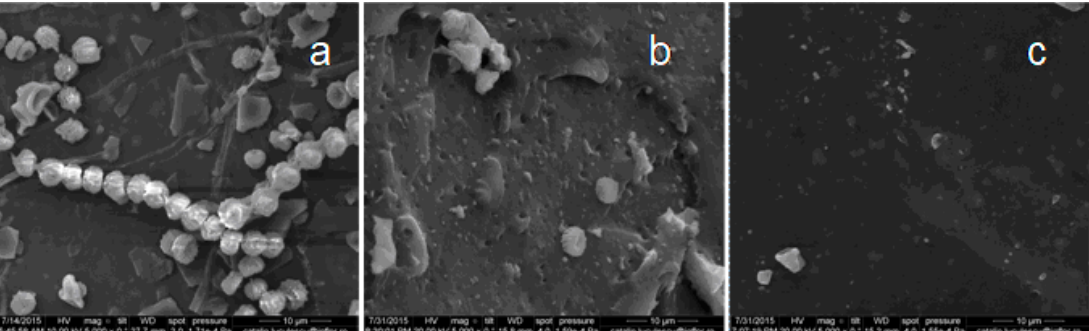
Figure 17. SEM of the natural rubber vulcanizate (A sample). ( a ) after 60 days of incubation with Aspergillus niger ; ( b ) after 60 days of incubation with Aspergillus niger and after 72 h immersed in toluene; ( c ) the blanks (before incubation with the Aspergillus niger ) and after 72 h immersed in toluene.